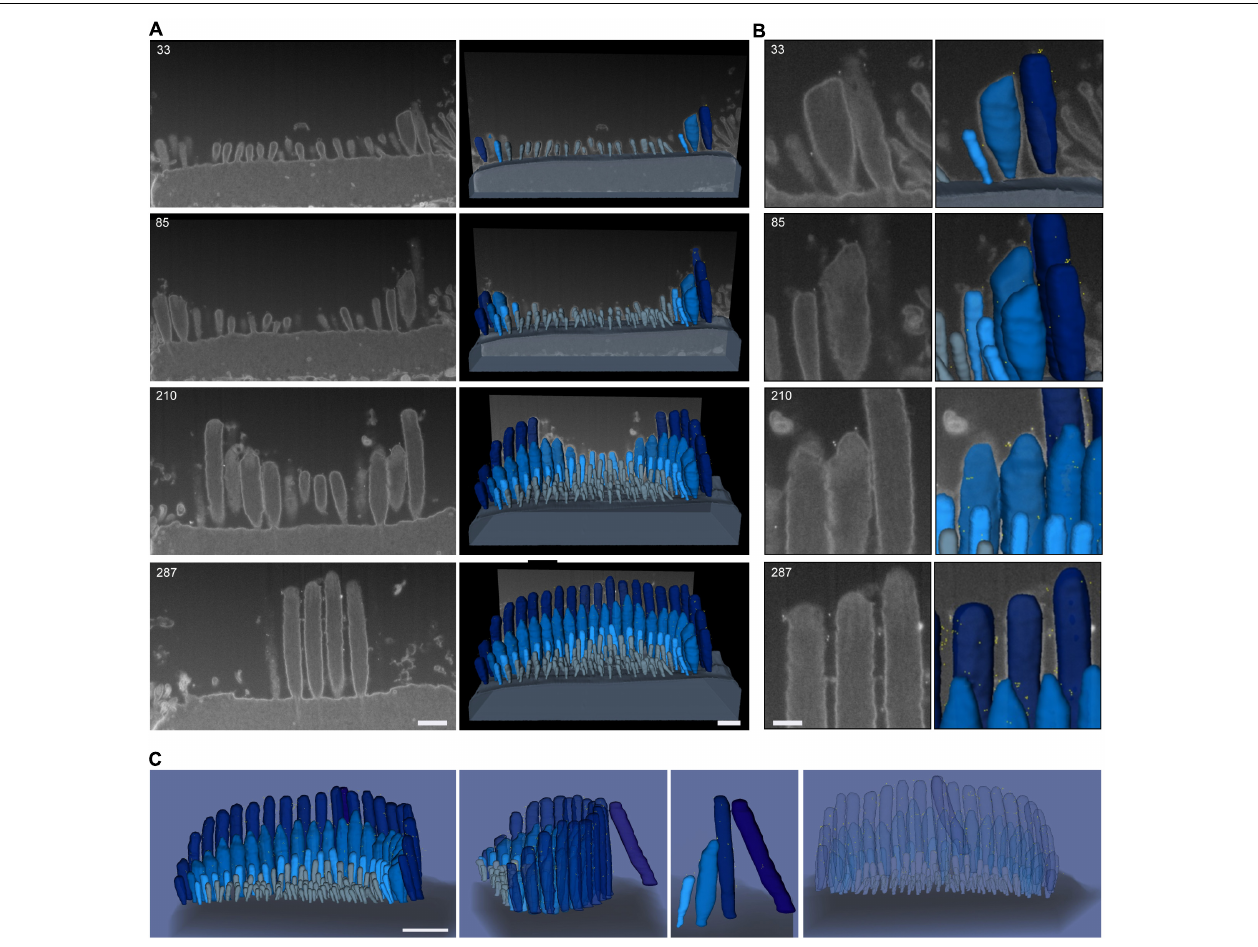
FIGURE 8 | Representative FIB-SEM of IHC hair bundles of neonatal (P1) mouse cochlea. Samples were immunostained with anti-PCDH15 primary antibody and gold-conjugated secondary antibody (12 nm gold). (A) Left, representative FIB-SEM micrographs from four single planes; right, a 3-D rendering of the FIB-SEM image stack. (B) An inset from (A) showing a closer view of the stereocilia and gold beads at their tips. Sample was imaged with a field-emission FEI Helios 660 FIB-SEM using BSE detection mode. (C) 3-D representation of an IHC stereocilia bundle labeled with anti-PCDH15 immunogold (12 nm) (426 serial FIB-SEM cross sections, at 10 nm milling step; yellow, gold beads; blue, stereocilia; light gray, microvilli; dark gray, cell body). At this age, PCDH15 is diffusely located near stereocilia tips. Scale bars: (A) 500 nm; (B) 200 nm; (C) 1 µ